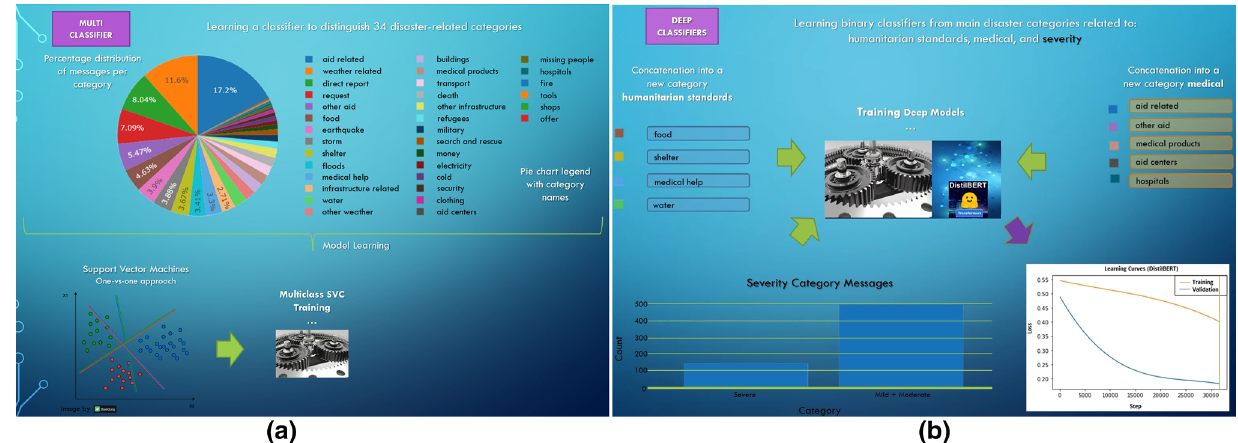
Fig. 3 a Multiclass classification approach to learn an SVC model to distinguish the 34 disaster categories of the MDRM dataset. The disas- ter-related categories are shown along with their distribution percentages of sample messages for each category; b Binary classification approach of deep learning models with bidirectional Transformer neural network models. We fine-tune one model for each group of main disaster categories: disaster-related, humanitarian standards, medical, and severity. The deep model of severity is fine-tuned on the Unified- CEHMET dataset, and we show the number of messages for each grouped category of severity